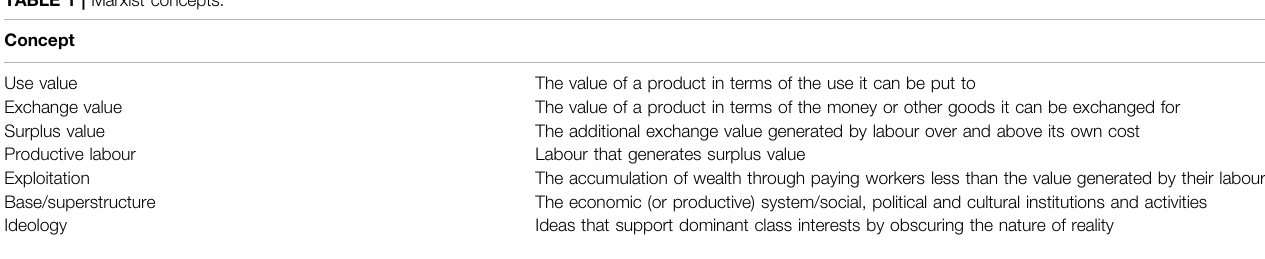
TABLE 1 | Marxist